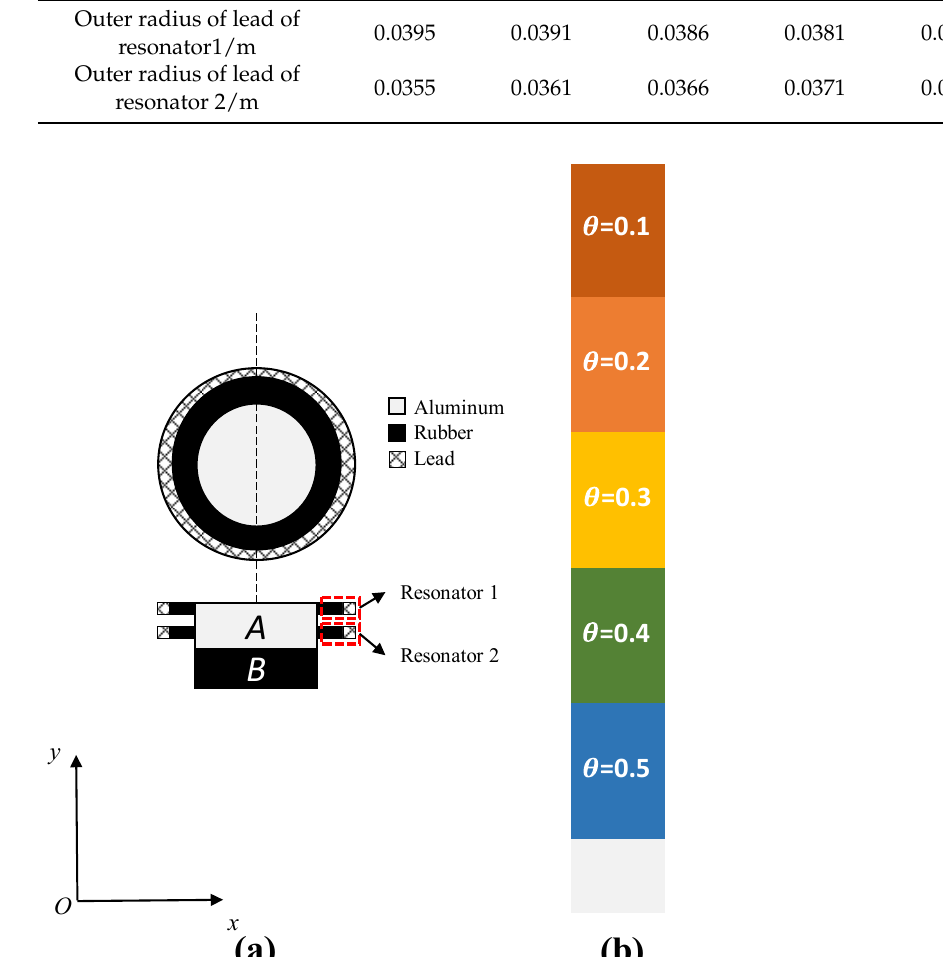
Figure 10. Diagrammatic sketches of the continuum strut by reverse design: ( a ) General schematic diagram of unit cells. ( b ) Rainbow segmentation schematic of the strut with graded parameter θ